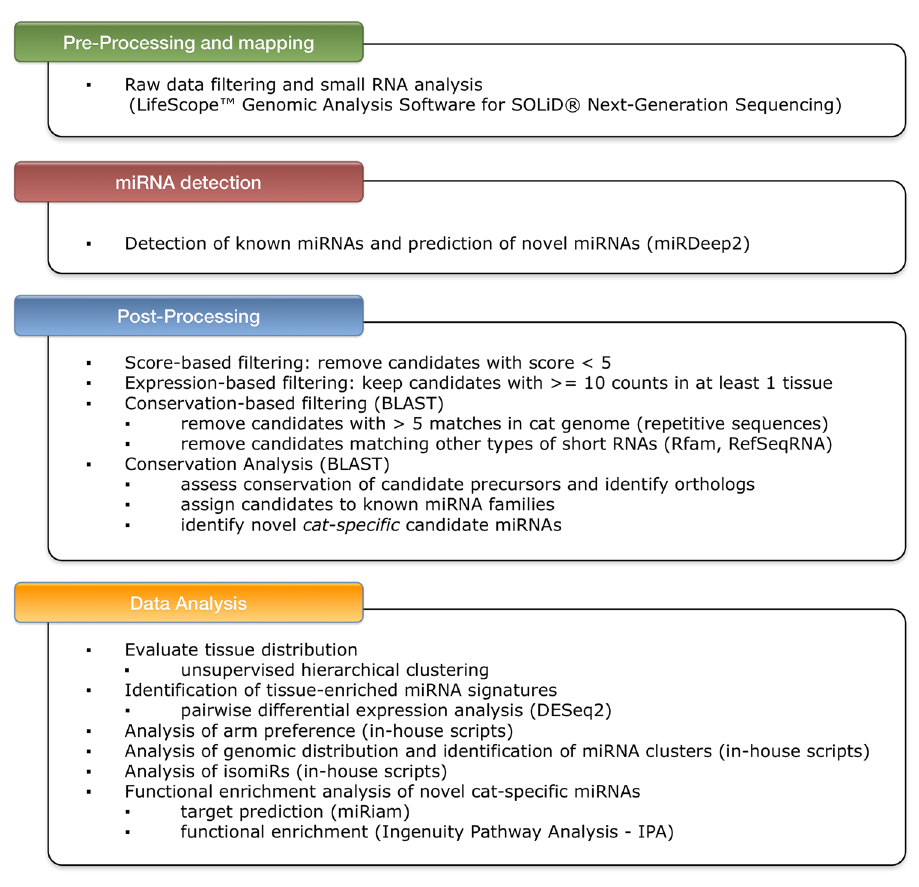
of ad-hoc scripts for the extraction of descriptive statistics. The tool IPA was used to perform the functional enrichment analysis of potential targets of the identified miRNAs, which were predicted by the software